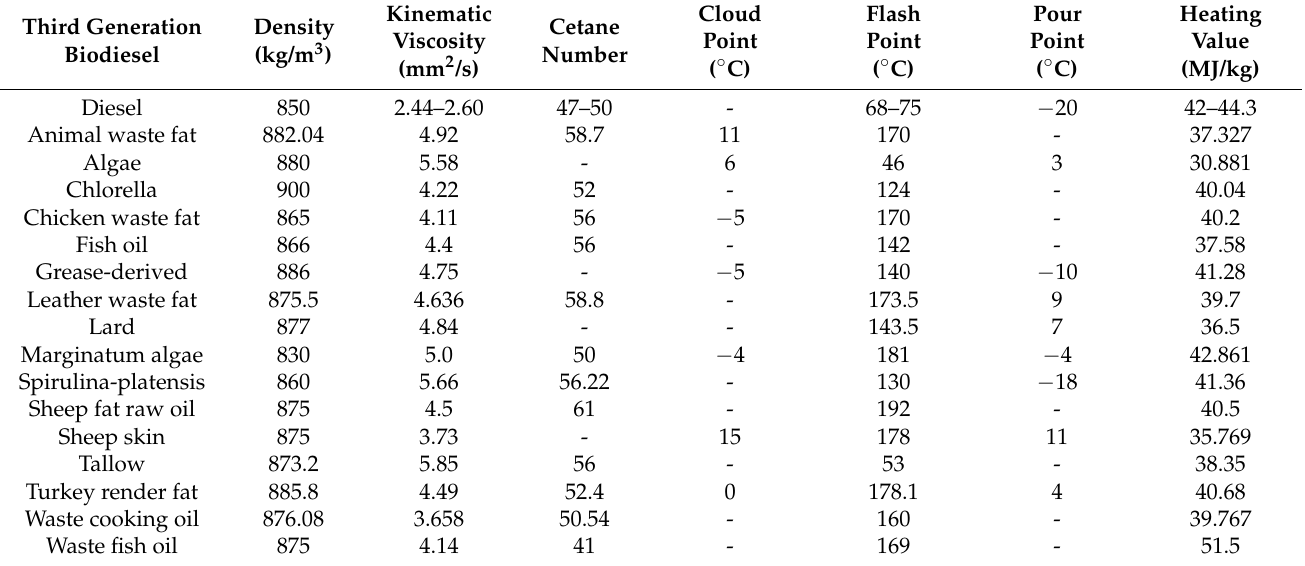
Table 6. Properties of third-generation biodiesel